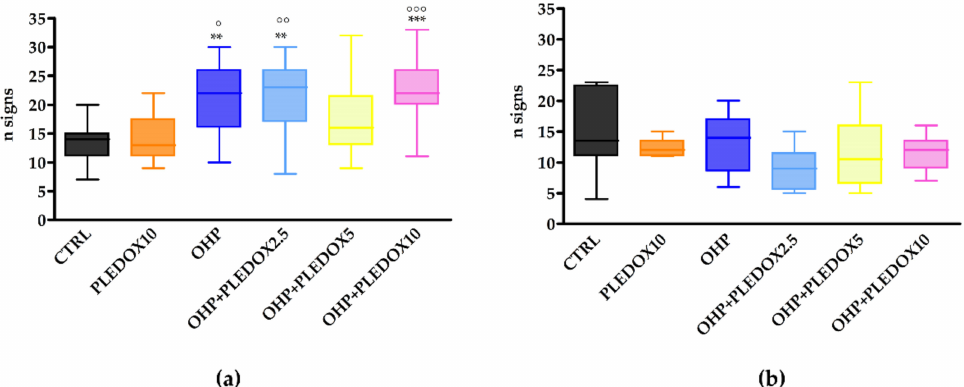
Figure 4. Cold Plate Test at the end of treatment ( a ), and at the end of the follow-up period ( b ). ◦ p < 0.05 vs. PLEDOX, ◦◦ p < 0.01 vs. PLEDOX, ◦◦◦ p < 0.001 vs. PLEDOX, ** p < 0.01 vs. CTRL, *** p < 0.001 vs. CTRL, Kruskal-Wallis test.